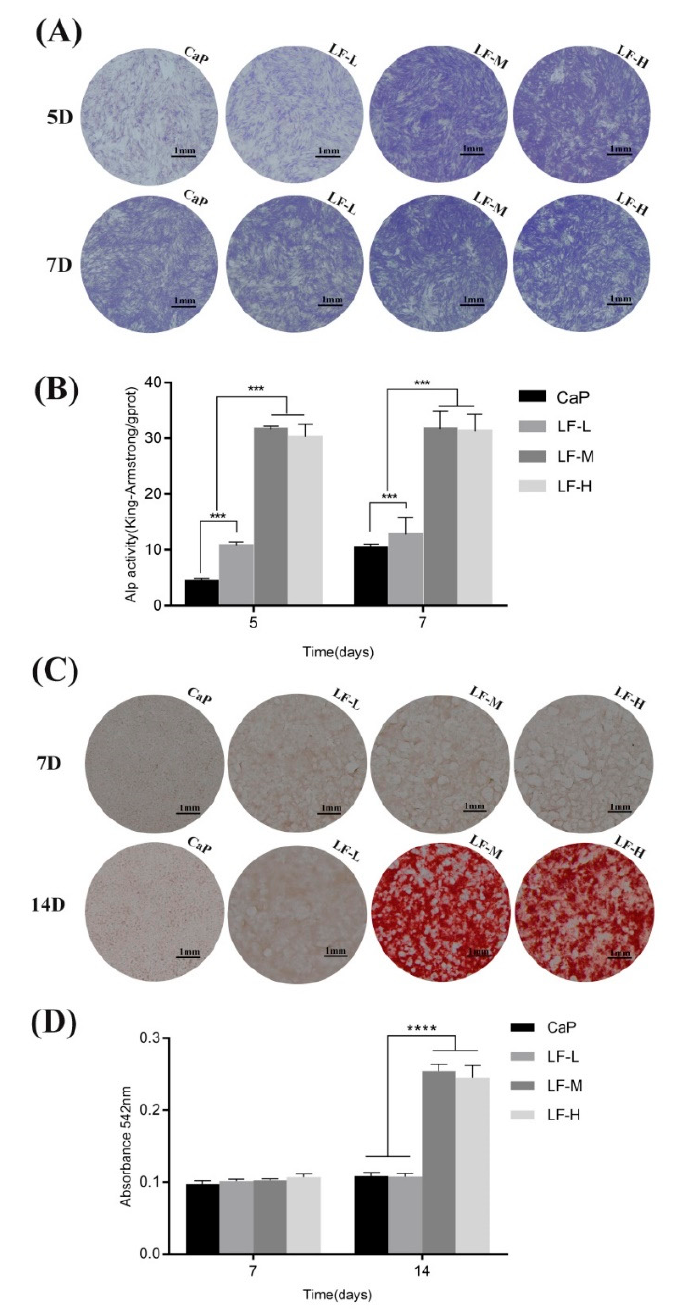
Figure 8. ( A ) Alkaline phosphatase (ALP) staining of BMSCs of CaP, LF-L, LF-M, and LF-H groups for 5 and 7 days; ( B ) quantitative ALP activity of the BMSCs of the CaP, LF-L, LF-M, and LF-H groups for 5 and 7 days; ( C ) matrix mineralization of BMSCs of the CaP, LF-L, LF-M, and LF-H groups for 7 and 14 days; ( D ) colorimetric quantitative results of extracellular matrix mineralization. *** p < 0.001, **** p < 0.0001.